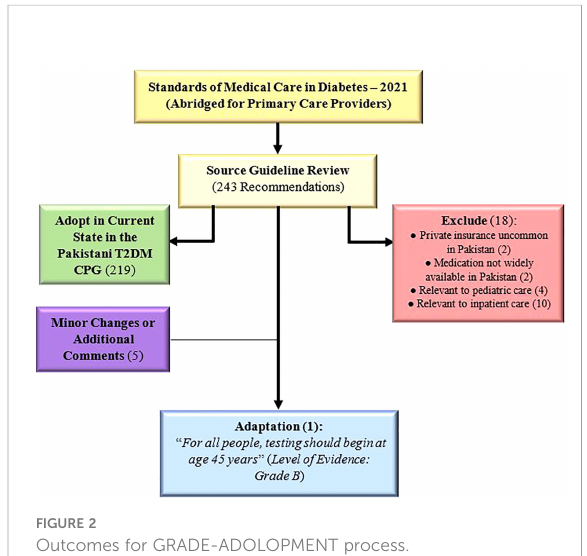
FIGURE 2 Outcomes for GRADE-ADOLOPMENT